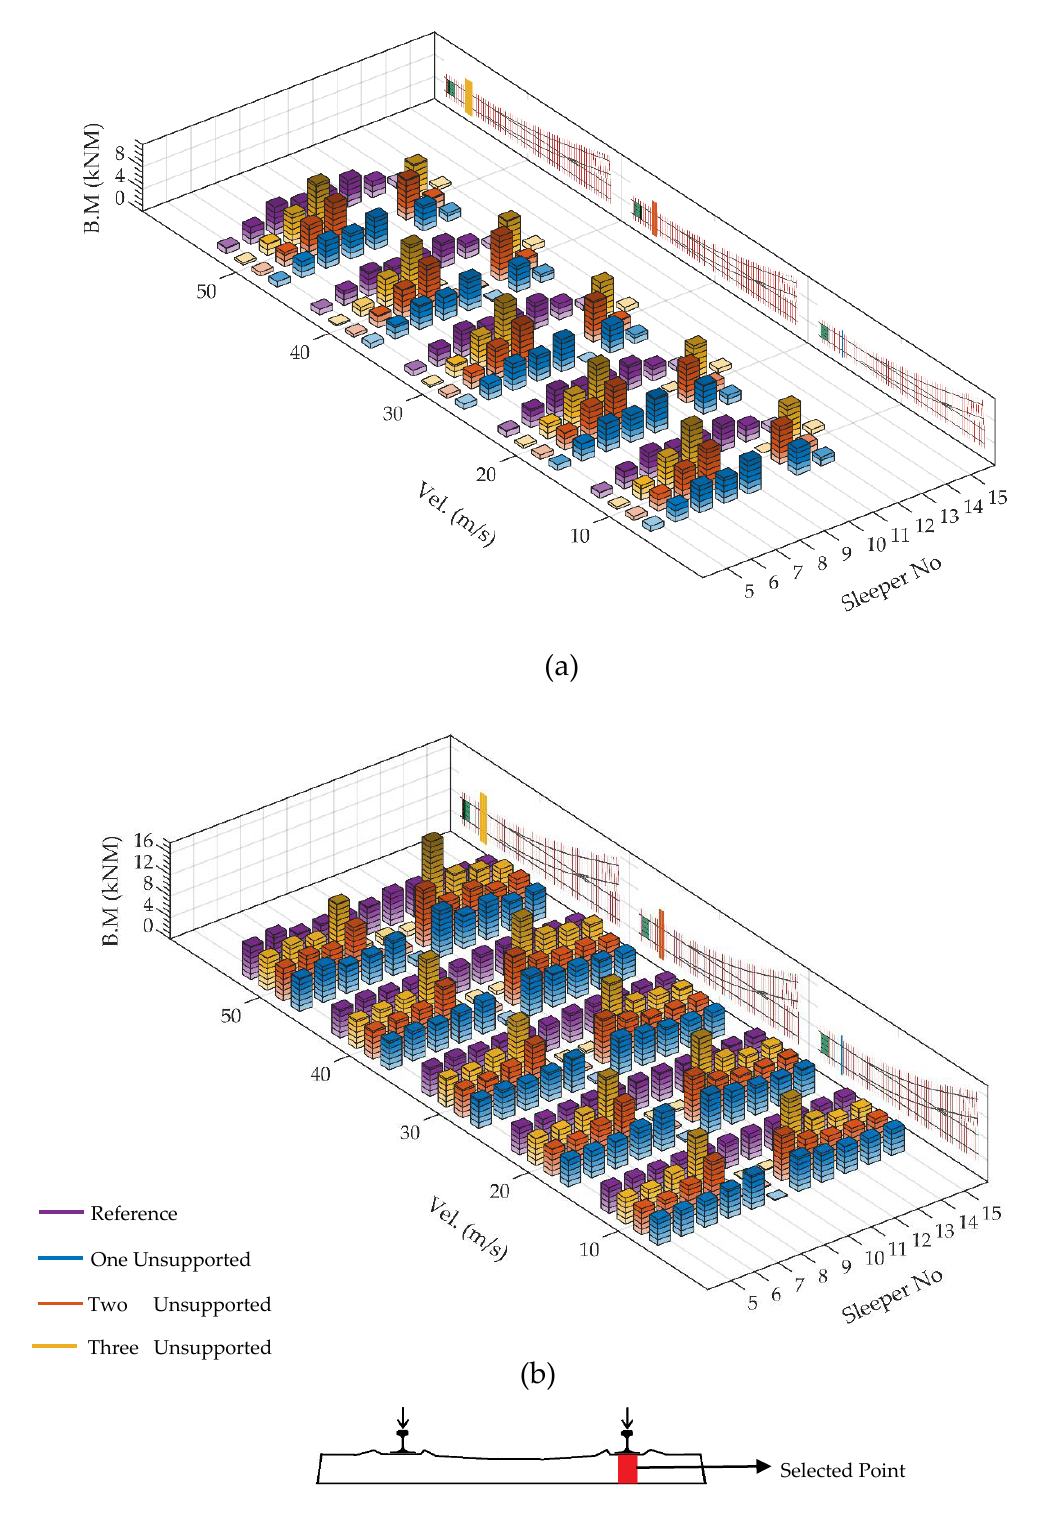
Figure 22. The distribution of positive bending moments over the bearers when unsupported bearers exist at normal track section: ( a ) at particular time when the front wheel is on the bearer with number 10; ( b ) when maximum occurs at each bearer.